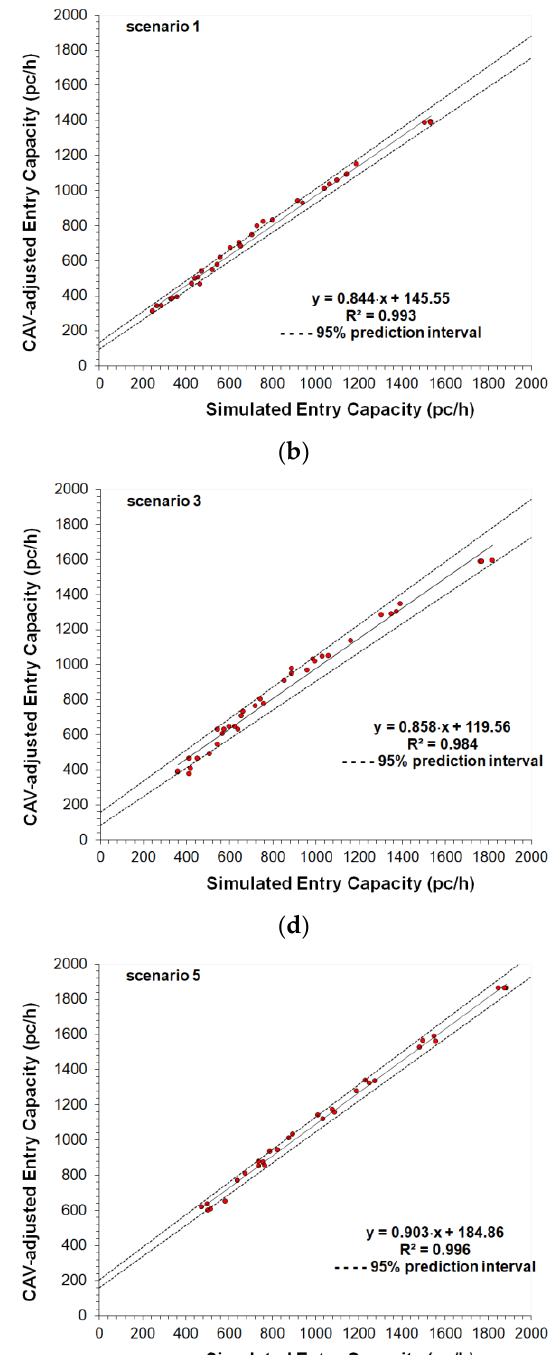
( f ) Figure 7. Comparisons between the CAV-adjusted and simulated entry capacity data for different market penetration rates of CAVs and HDVs for the entry mechanism 2 (i.e., the left entry lane of two-lane entry approach conflicted by two circulating lanes) listed as: ( a ) baseline scenario: 0% CAVs and 100% HDVs; ( b ) scenario 1: 20% CAVs and 80% HDVs; ( c ) scenario 2: 40% CAVs and 60% HVs; ( d ) scenario 3: 60% CAVs and 40% HDVs; ( e ) scenario 4: 80% CAVs and 20% HDVs; ( f ) scenario 5: 100% CAVs and 0% HDVs. Notes: to explain the entry mechanisms 2 reference has been made to the northbound left entry lane entry in Figure 4a; the black line and dotted red line regres- sions were extrapolated by the data.